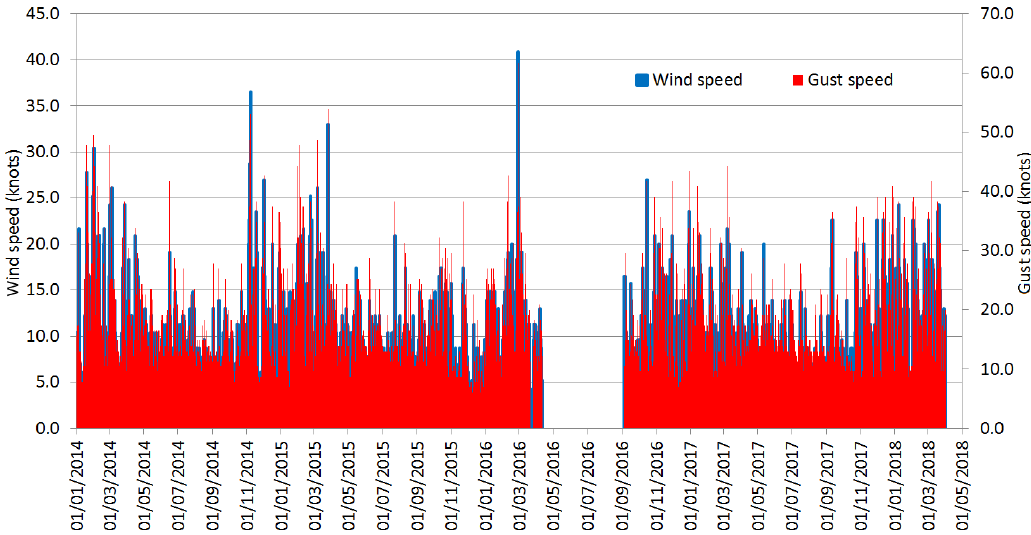
Figure 17. Wind and gust speed time series data showing daily, seasonal and annual variation patterns at the Denza station during 2014–2018. Table 9. Monthly average values of wind measures during 2014–2018.